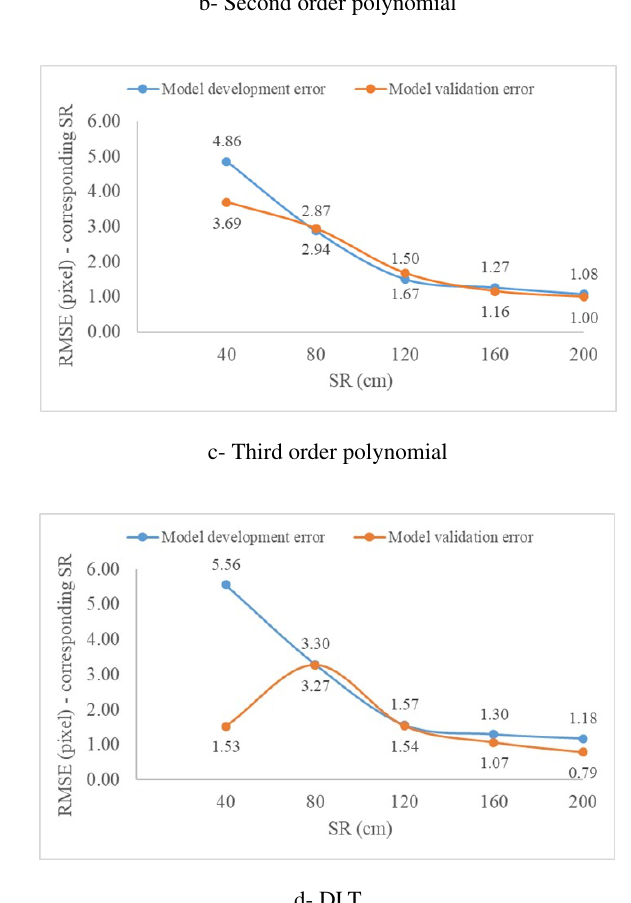
Figure 10. Check points - Aerial and LiDAR data (20 cm) Figure 11. Registration models’ evaluation at different